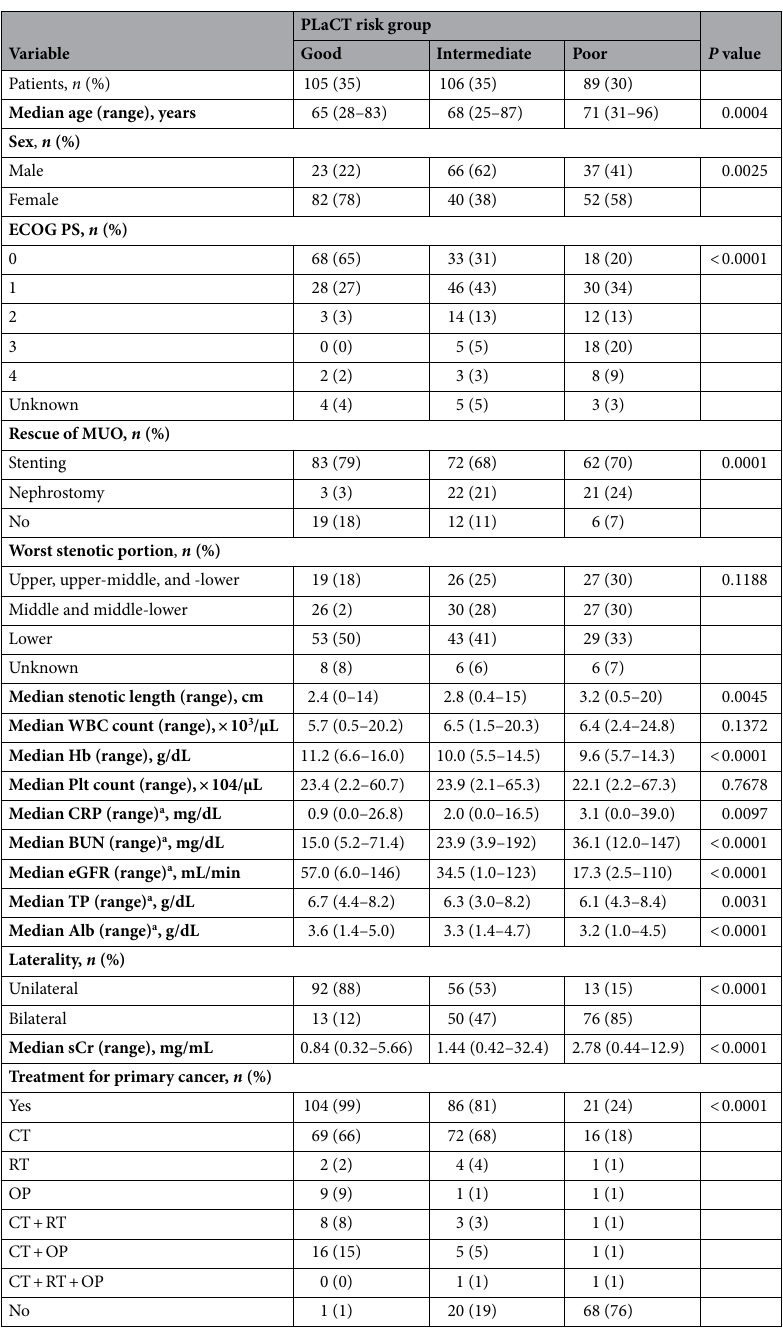
Hb hemoglobin, Plt platelet, CRP c-reactive protein, BUN blood urea nitrogen, eGFR estimated glomerular filtration rate, TP total protein, Alb albumin, CT chemotherapy, RT radiotherapy, OP operation. a The